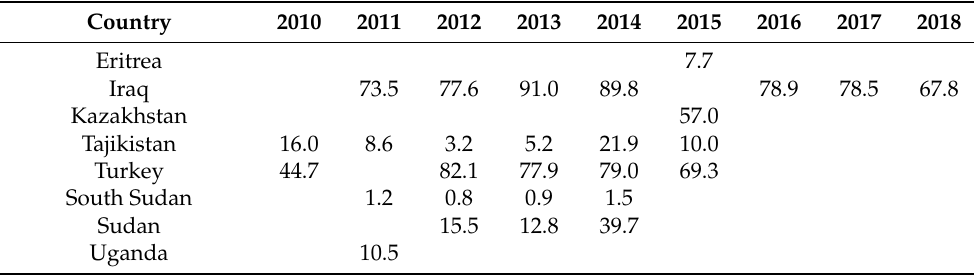
Table 3. Countries’ reports of vaccination coverage during road map meetings. Numbers show the percentage of the small ruminant population